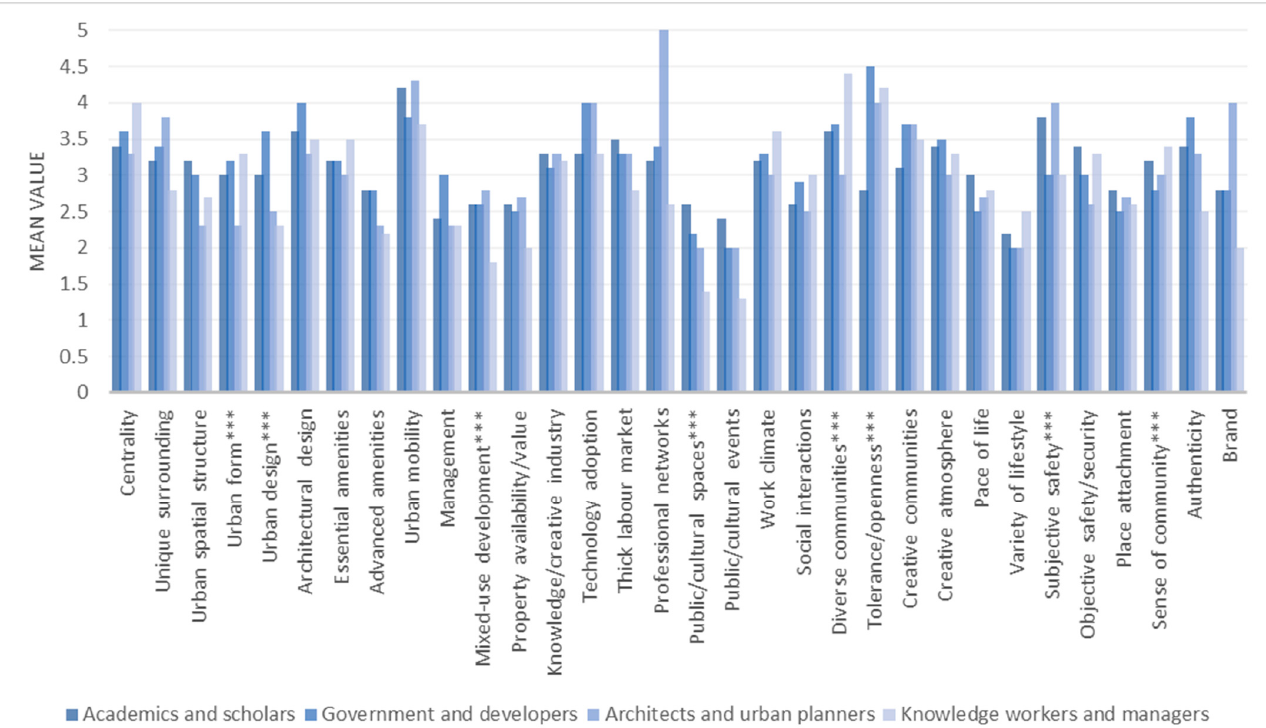
Figure 2. Quantitative evaluation of place characteristics in Diamantina Knowledge Precinct.